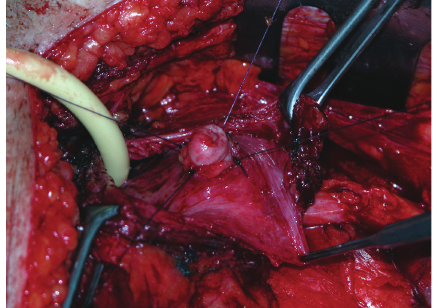
Figure 1: Simplified split-cu ff technique of ureteral reimplantation, consisting in the confection of a nipple of the intravesical ureter for a length about the double of its diameter: intraoperative appear- ance.